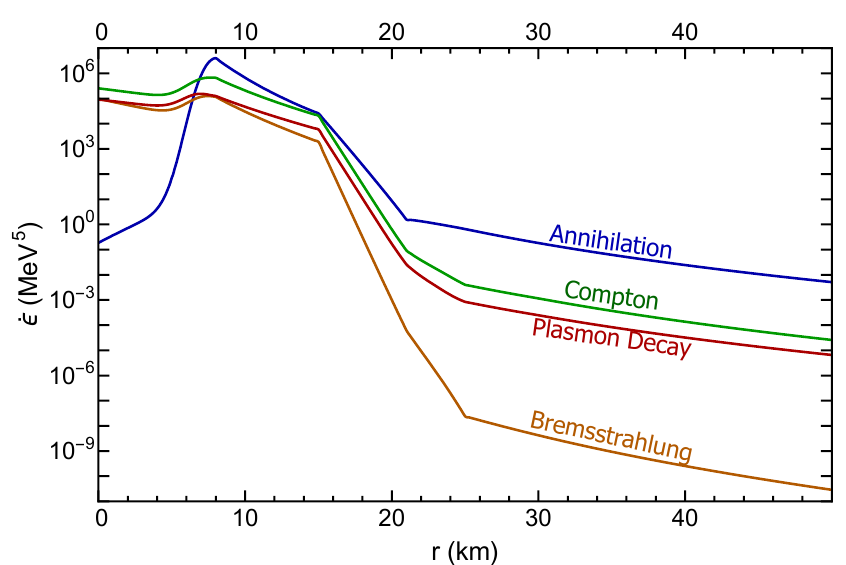
Figure 3 . A plot of the emissivities of the various processes that produce axions and dark photons as a function of radius of the supernova. These emissivities are taken for both the dark photon and axion massless. The annihilation process is the dominant process everywhere in the supernova except for near the center of the supernova where it is suppressed by the low density of positrons. The coupling has been set to f a = 1 MeV for